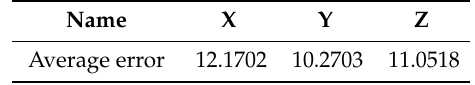
Table 3. Coordinate points list (Two sets of coordinate points).